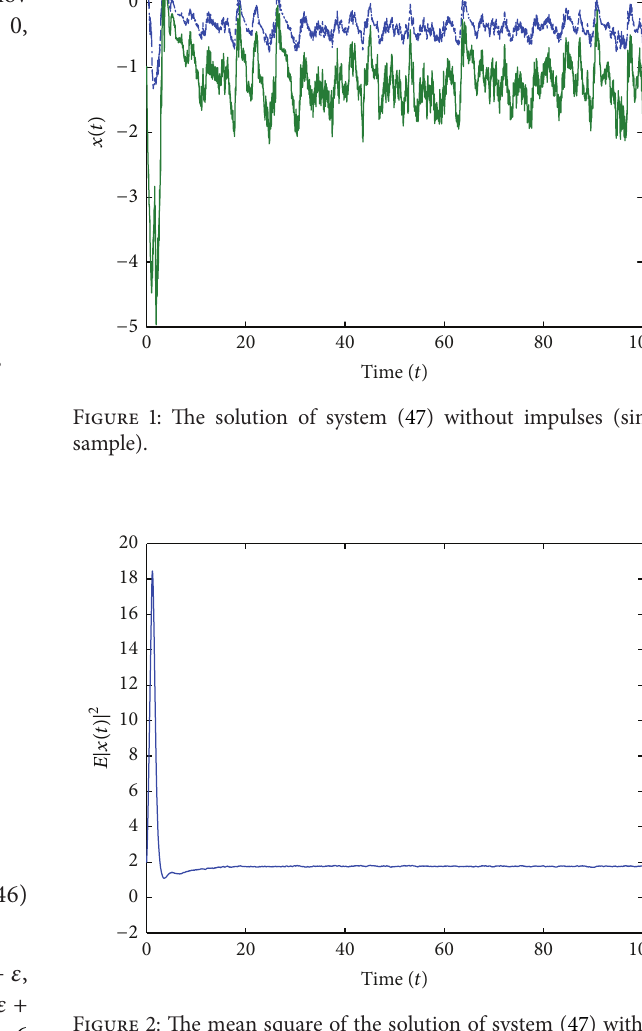
Figure 2: The mean square of the solution of system (47) without impulses (2000